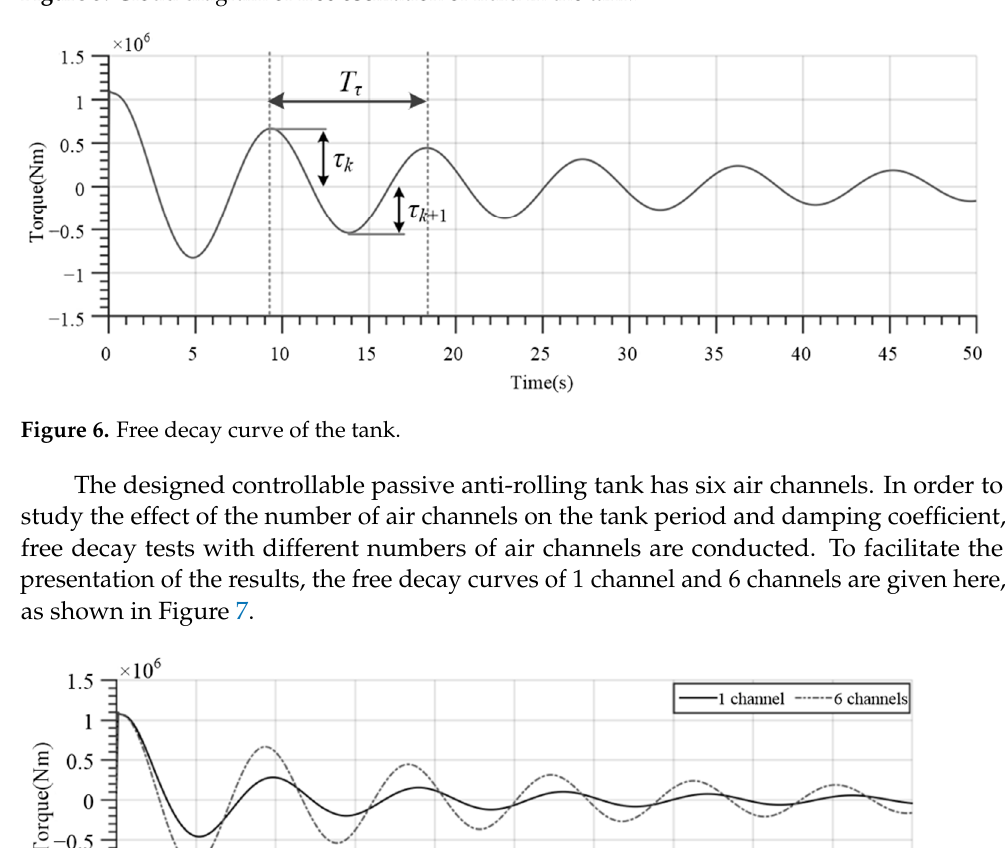
Figure 6. Free decay curve of the tank.